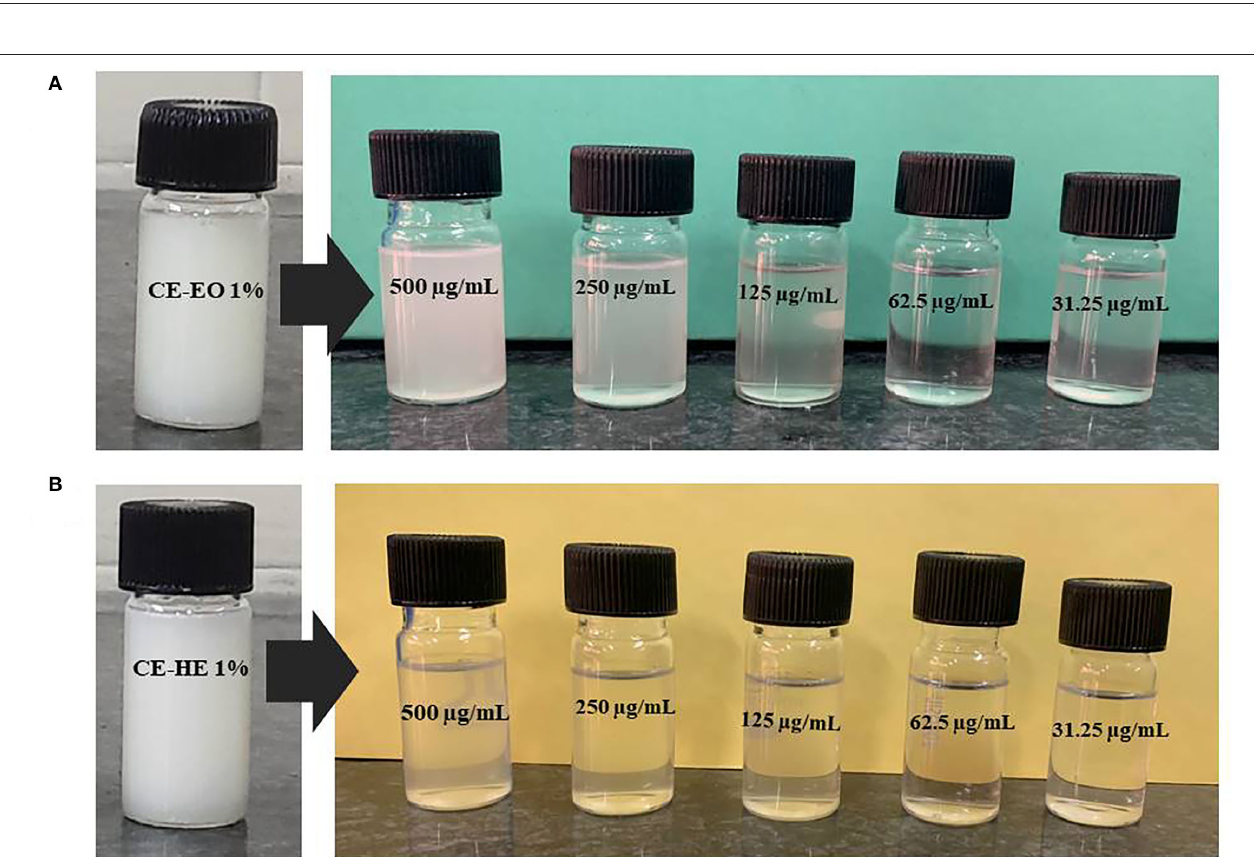
FIGURE 3 | Visual appearance of CEs and different concentrations of NEs of (A) EO and (B) HE of P. cablin.